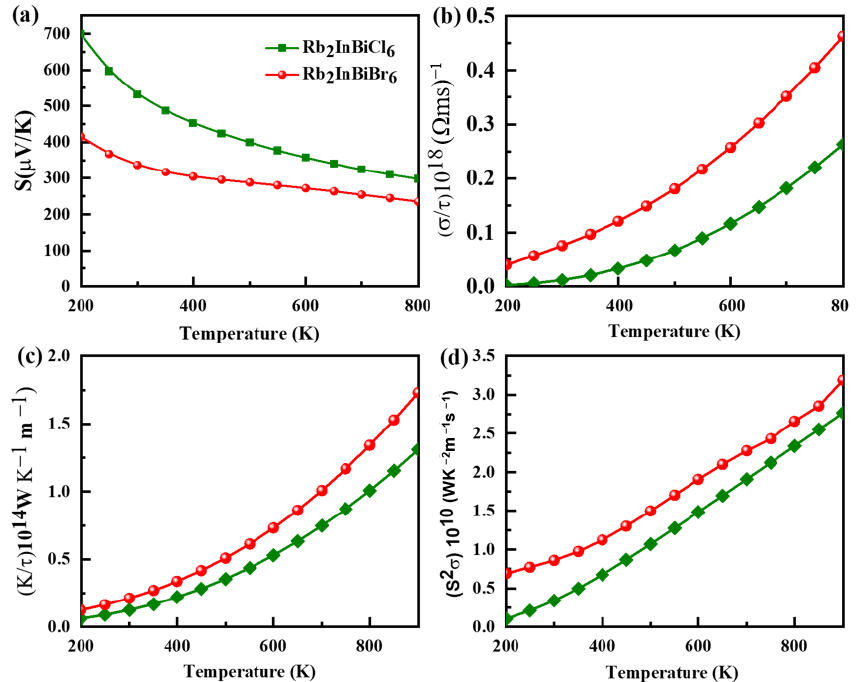
Figure 7. Computed values of ( a ) Seebeck coefficient (s), ( b ) electrical conductivity ( σ / τ ), ( c ) thermal conductivity (κ/τ) , ( d ) power factor (S 2 σ) with temperature.